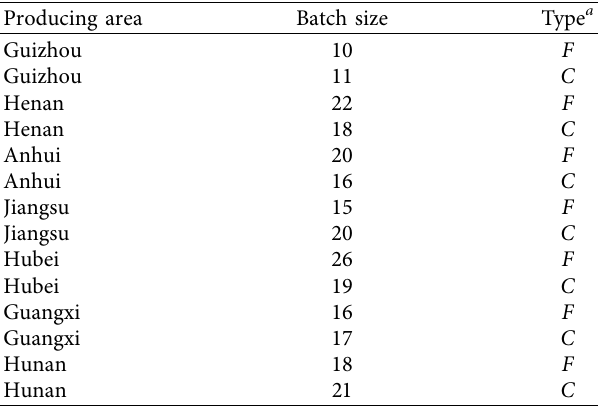
Table 1: Detailed information of the free-range and caged eggs analysed.